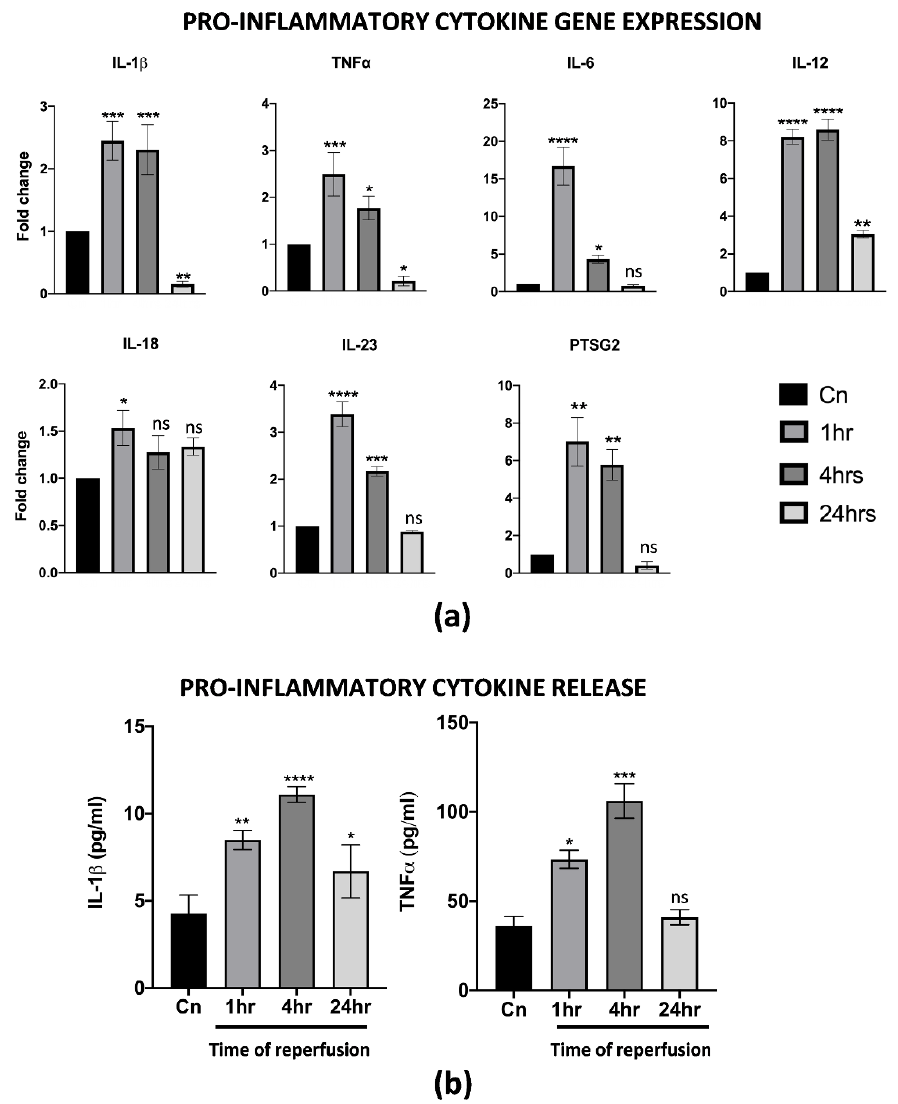
Figure 2. PBMC derived M1-like macrophages displayed a pro-inflammatory phenotype upon IRI. ( a ) Gene expression analysis of pro-inflammatory genes in reperfused M1-like macrophages at different timepoints. The comparison has been conducted by using the ∆∆ CT method and normalized to GAPDH transcript. Statistical significance has been calculated via ordinary one-way ANOVA (Dunnet’s multiple comparisons test, n = 3, * = p < 0.05; ** = p < 0.005; *** = p < 0.0005; **** = p < 0.0001; ns = not significant). ( b ) IL-1 β and TNF α protein quantification in the conditioned medium of reperfused macrophages at different timepoints. Protein concentration has been calculated according to the standard curve of each ELISA assay ( n = 3). Statistical significance has been calculated via ordinary one-way ANOVA (Dunnet’s multiple comparisons test, n = 3, * = p < 0.05; ** = p < 0.005; *** = p < 0.0005; **** = p < 0.0001; ns = not